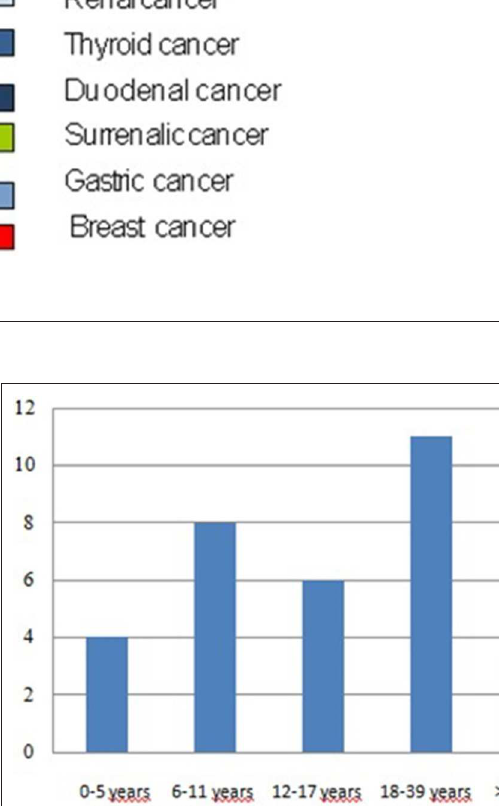
FIGURE 3 | Cases of tumors in patients with PID.